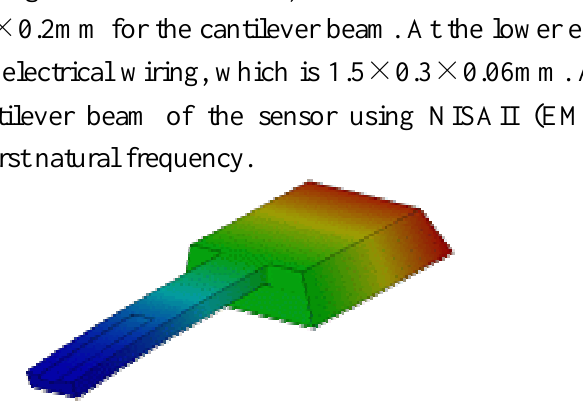
Figure 6. Modal analysis result of a modeled cantilever beam.